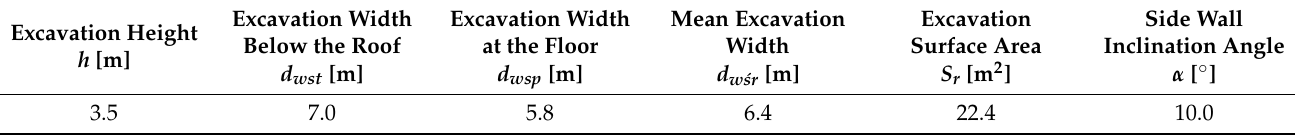
Table 5. Dimensions of the analyzed